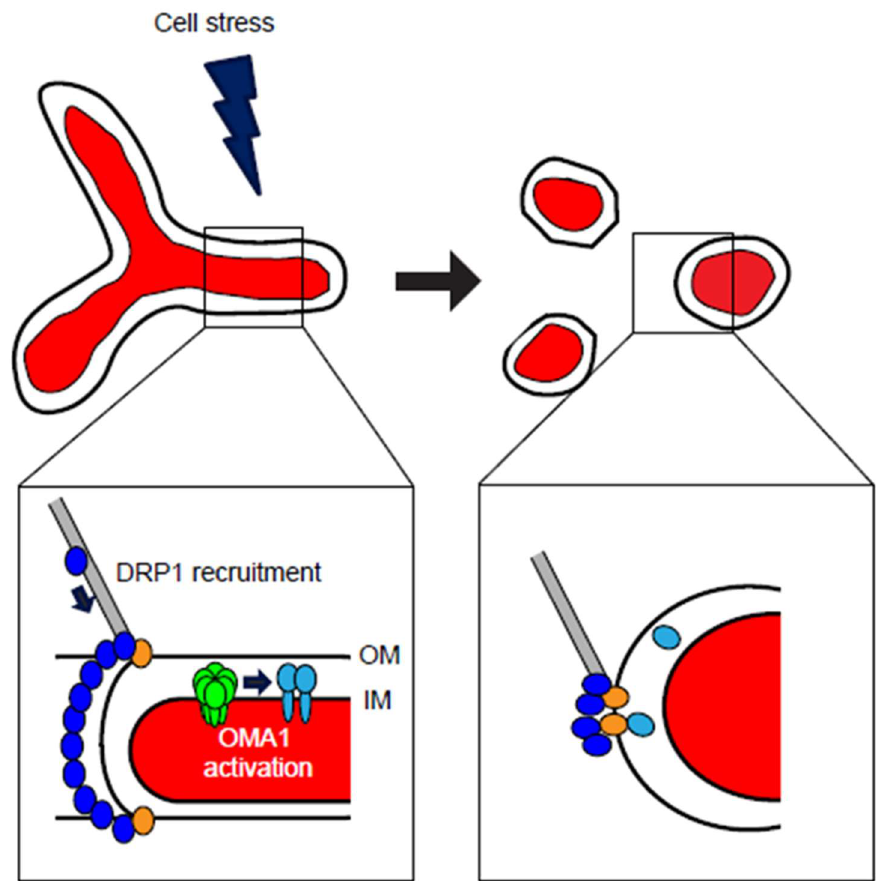
Figure 2. Cellular stresses induce mitochondrial fragmentation through DRP1- and OMA1-dependent mechanisms. At steady-state conditions, mitochondria maintain a balance of fusion and fission, with ability of organellar interconnection (top left). Cell stress, including cytokines, oxidants, bioenergetic deficits, or other stimuli, can activate either DRP1-mediated mitochondrial fission, OMA1-mediated loss of mitochondrial fusion, or both. Recruitment of DRP1 (blue) to the organelle is accomplished through cytoskeletal trafficking, where DRP1 is bound by mitochondrial receptors including MFF, Fis1, MiD49, and MiD51 (gold) at the outer membrane (OM) (detail image, lower left). At the inner membrane (IM), stresses that decrease ∆ ψ m may activate homo-oligomeric OMA1 (green), which responds by cleaving OPA1 (light blue) from its fusion-active L-OPA1 isoforms to the fusion-inactive S-OPA1. Upon activation of these responses, mitochondrial form is remodeled to a fragmented morphology (top right), in which neither OM nor IM are interconnected. Following DRP1 multimeric constriction and division of the organelle, DRP1 remains localized at punctate foci with its mitochondrial receptor proteins, while the cleaved S-OPA1 is released from the inner membrane into the intermembrane space, with some S-OPA1 colocalizing at DRP1 fission sites (detail image, lower right).